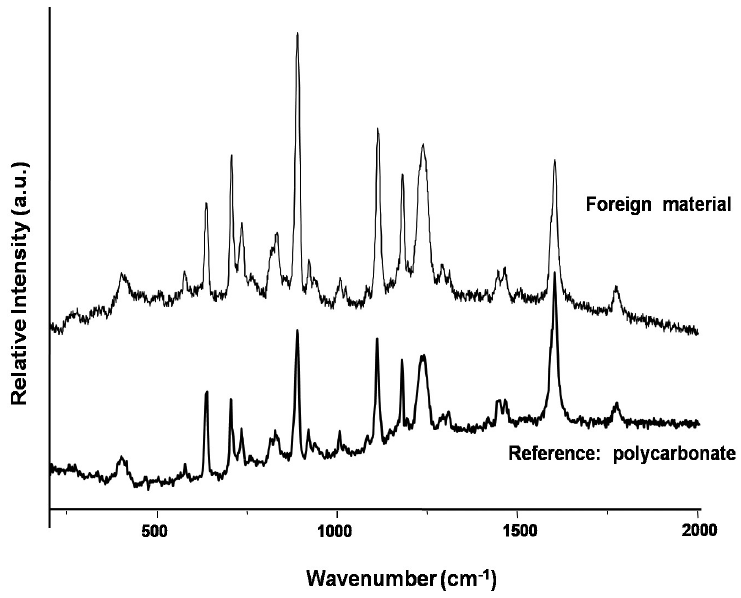
Figure 7. Case 3: Confocal laser Raman microprobe spectrum of a non-metallic fragment identified as